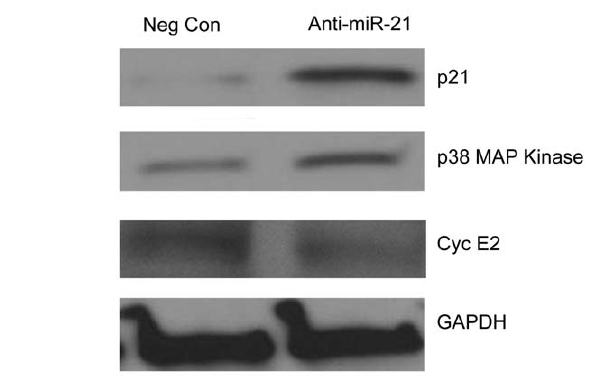
Figure 4. Western analysis after the knock down of miR-21 in A-498 cells. Expression of p21, p38MAP kinase and cyclin E2 after the inhibition of miR-21 in A-498 cells, as compared to negative control. GAPDH was used as a normalizing control. p21 and p38 MAP kinase were up regulated, whereas cyclin E2 expression was found to be down